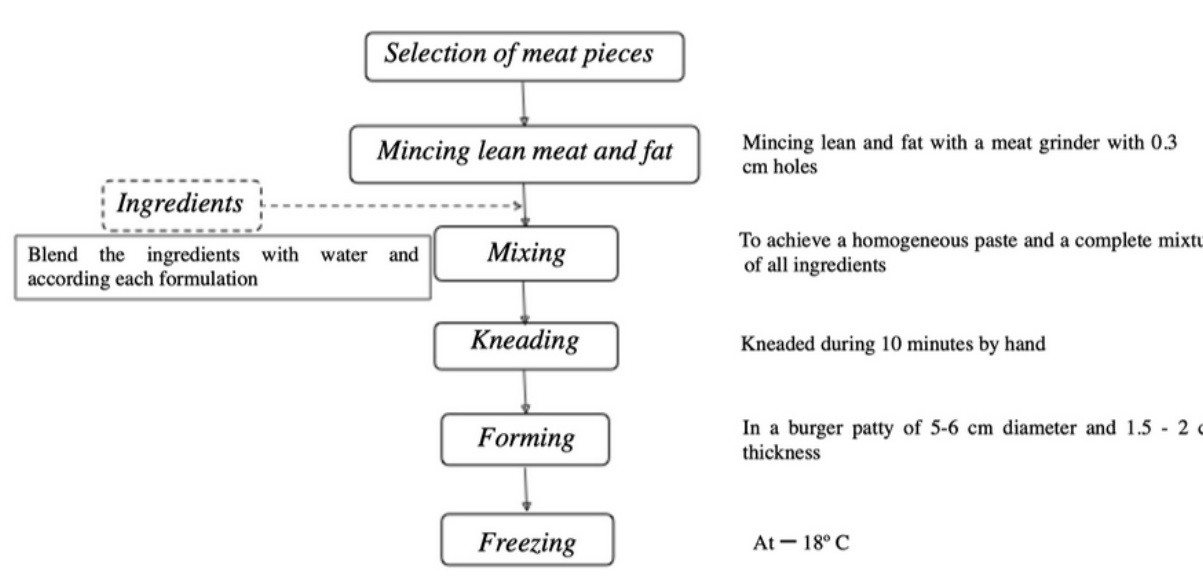
Figure 1. Flow chart of the fabrication of